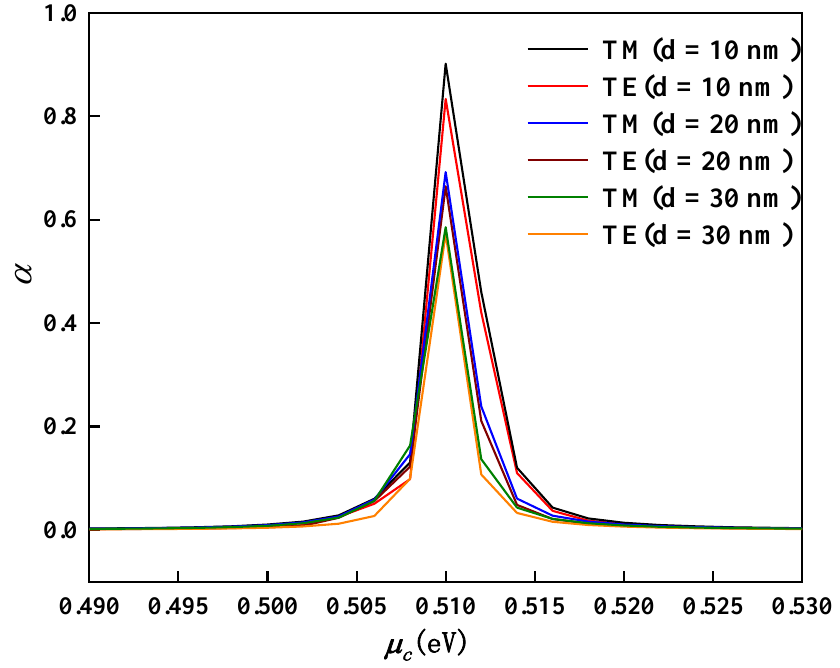
Figure 8. When the thickness d of the isolation layer is equal to 10 nm, 20 nm, 30 nm, the imaginary part of the effective refractive index changes with the chemical potential.